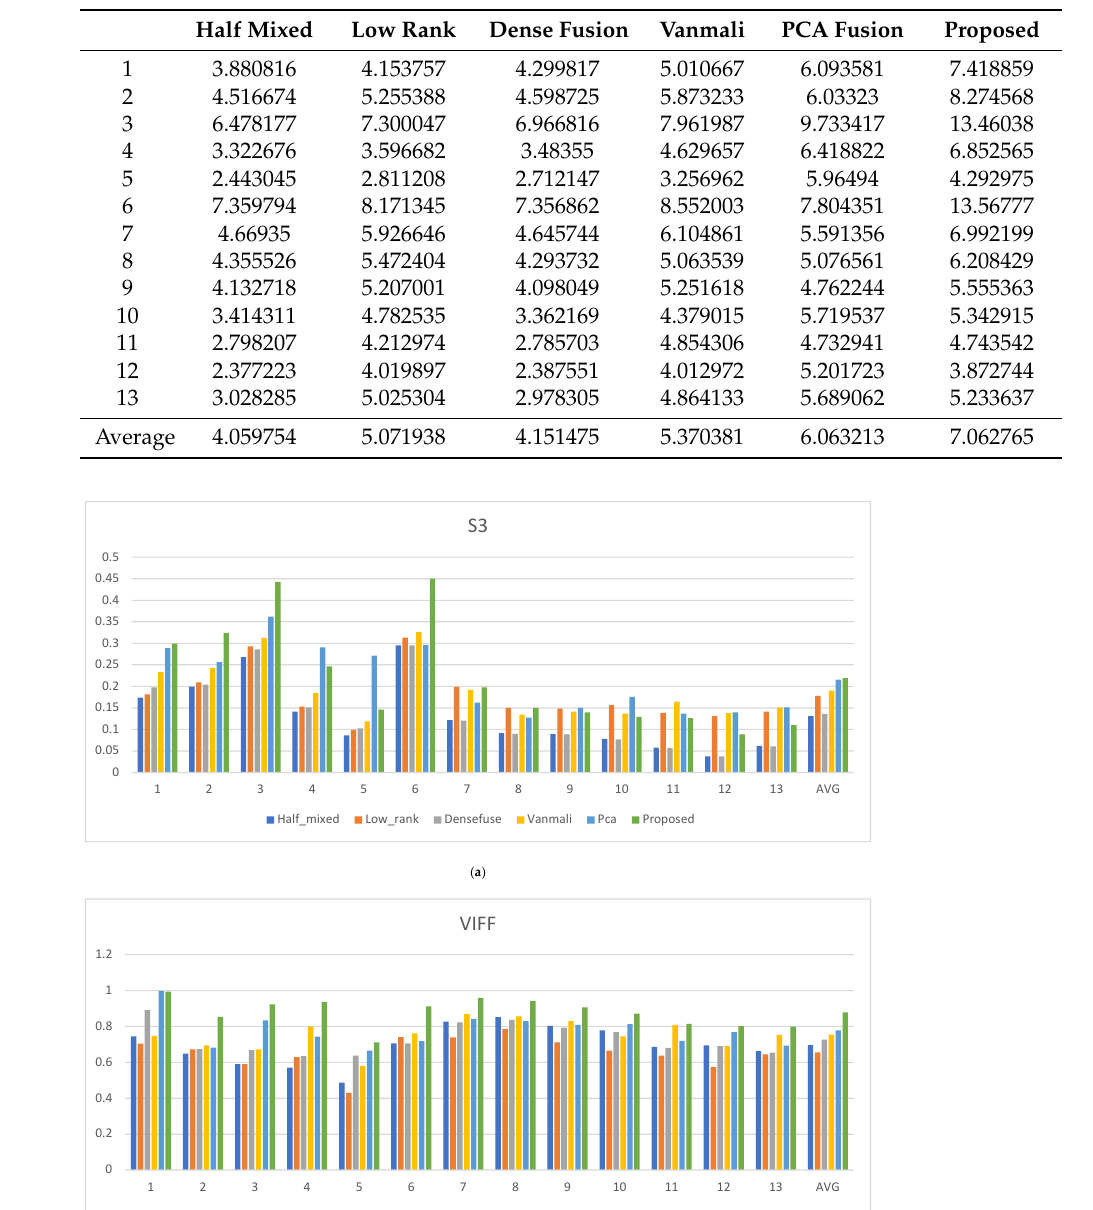
Table 6. Comparison of the average gradient metrics.